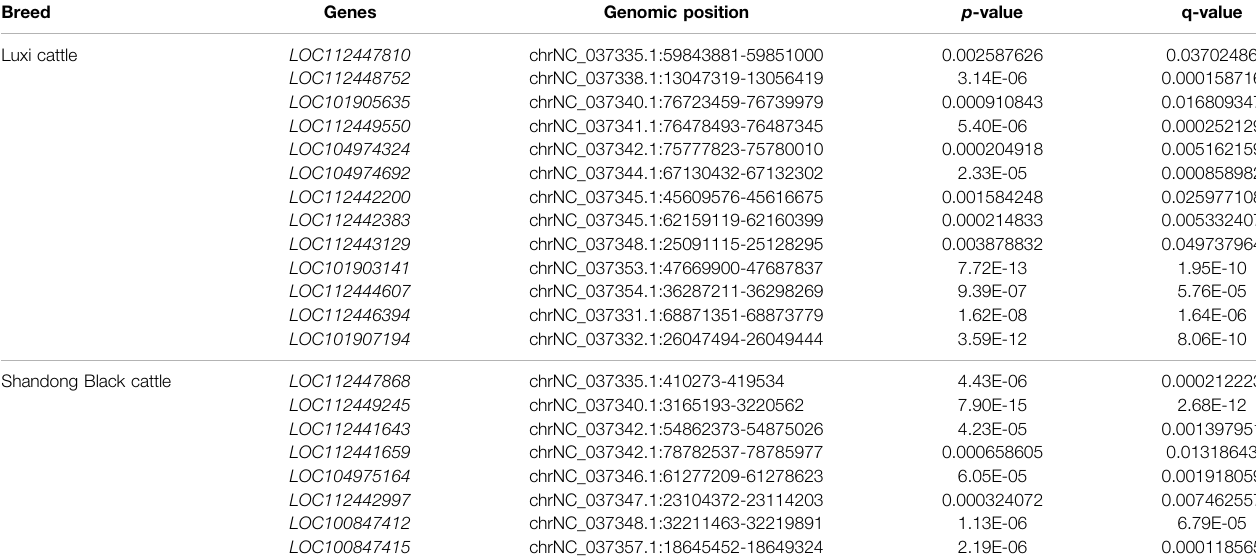
TABLE 4 | LncRNA specially expressed in Shandong Black cattle and Luxi cattle.